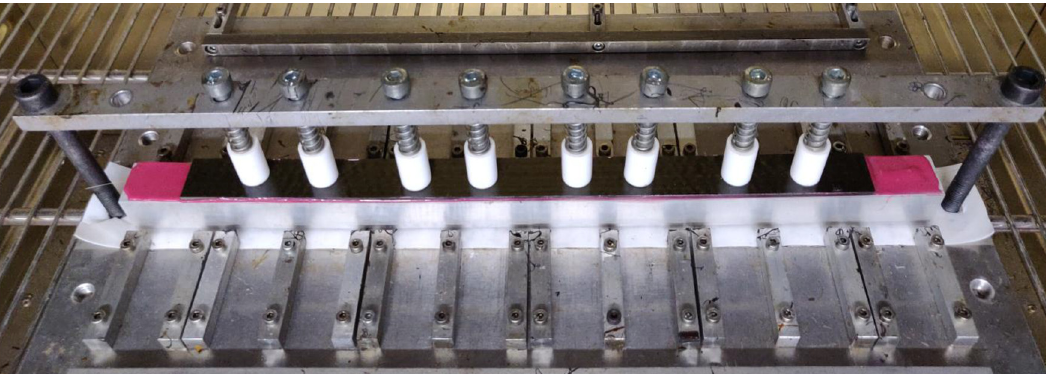
Fig. 4. Specimen and fi xture in oven.